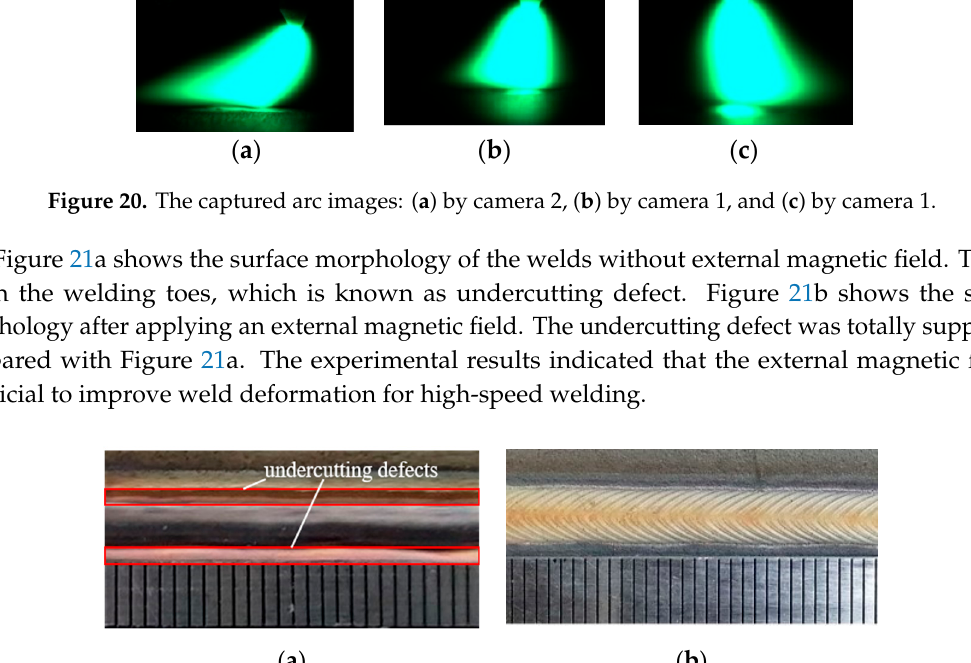
Figure 21. The surface morphology of weld: ( a ) I e = 0 and ( b ) I e = 3 A.